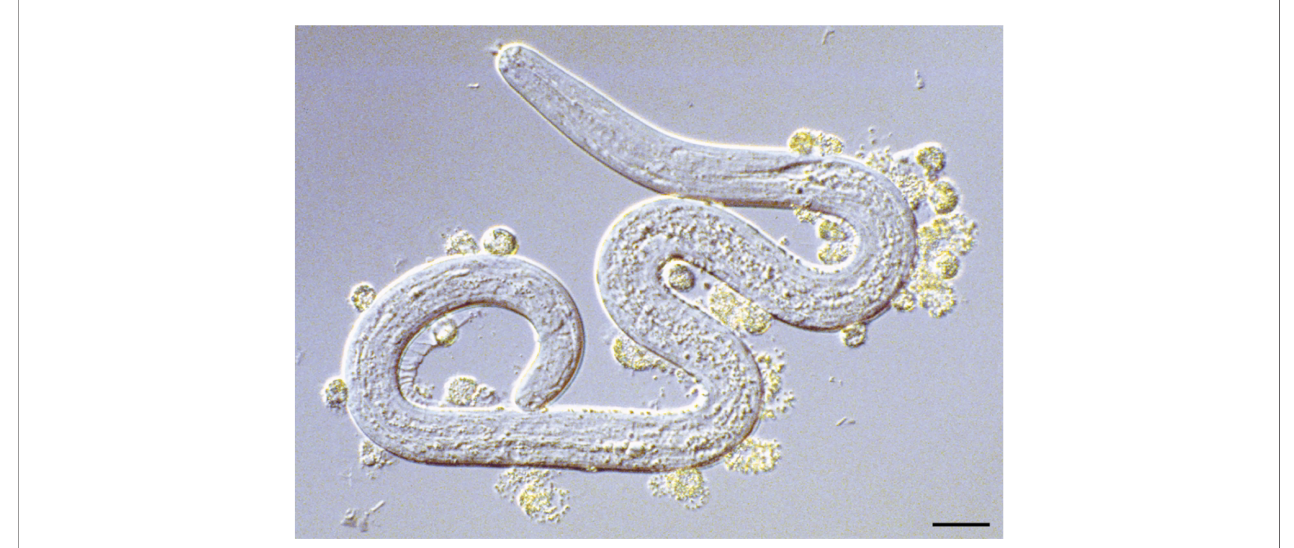
FIGURE 1 | Granulocytes attaching and degranulating on the surface of larval O. volvulus recovered from a diffusion chamber, implanted in mouse immunized with irradiated O. volvulus third-stage larvae, reprinted from Abraham et al. (2002), with